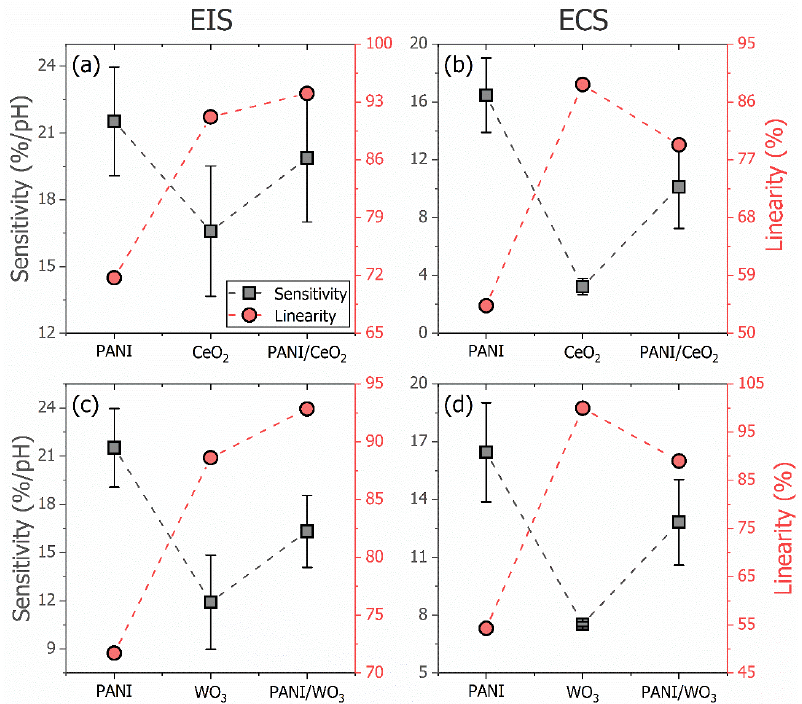
Figure 6. Comparison of the analytical values of merit (sensitivity and linearity) for the impedimetric (EIS) and capacitive (ECS) electrochemical sensors for each group of materials presented in this work. In ( a , b ), the EIS and ECS responses, respectively, of the CeO 2 group of films, and in ( c , d ), for the WO 3 group of films.